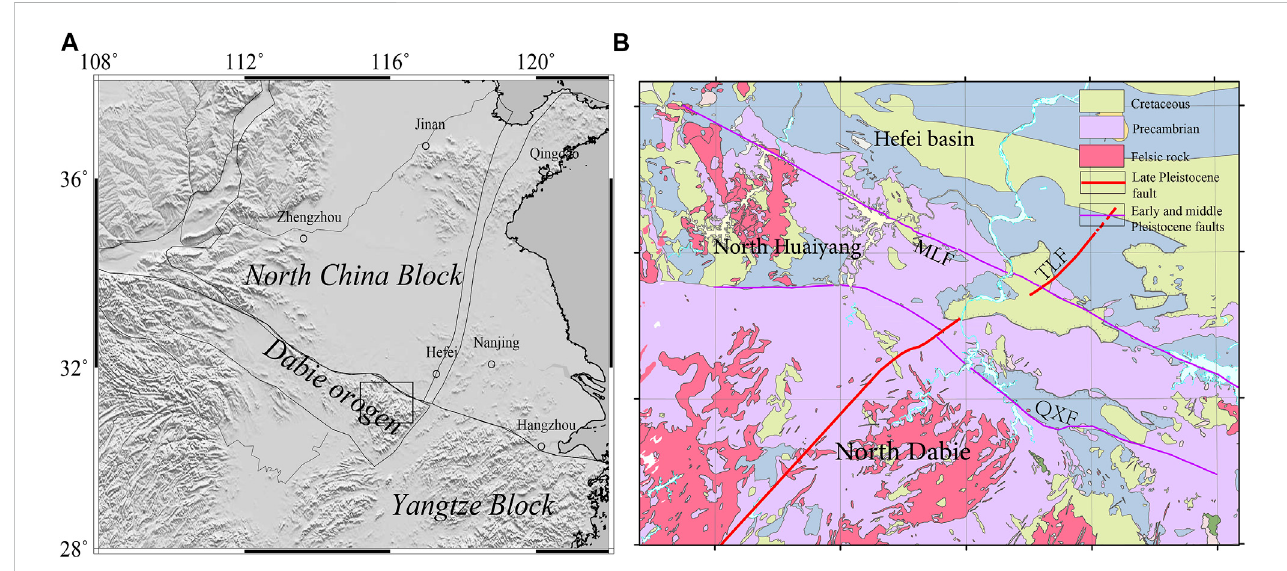
FIGURE 1 Topography (A) andGeologicalstructure (B) ofDabieorogenicbeltanditsadjacentareas(MLF:Meishan-LonghekouFault;QXF:Qingshan-XiaotianFault; TLF:Tudiling-Luoerling